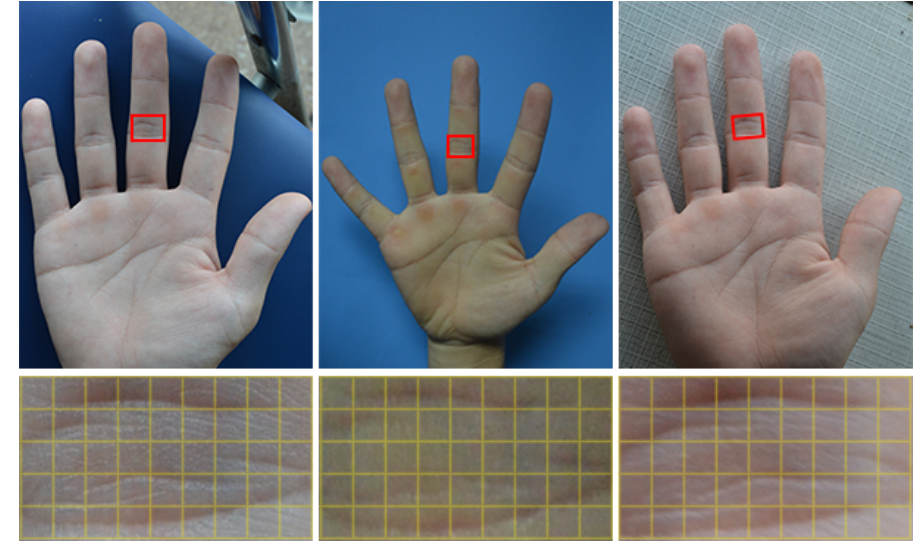
Figure 7. Three IKP images and their ROIs from the same finger node, but in different poses and viewpoints. The grids are used to show that the local deformations are often limited to small